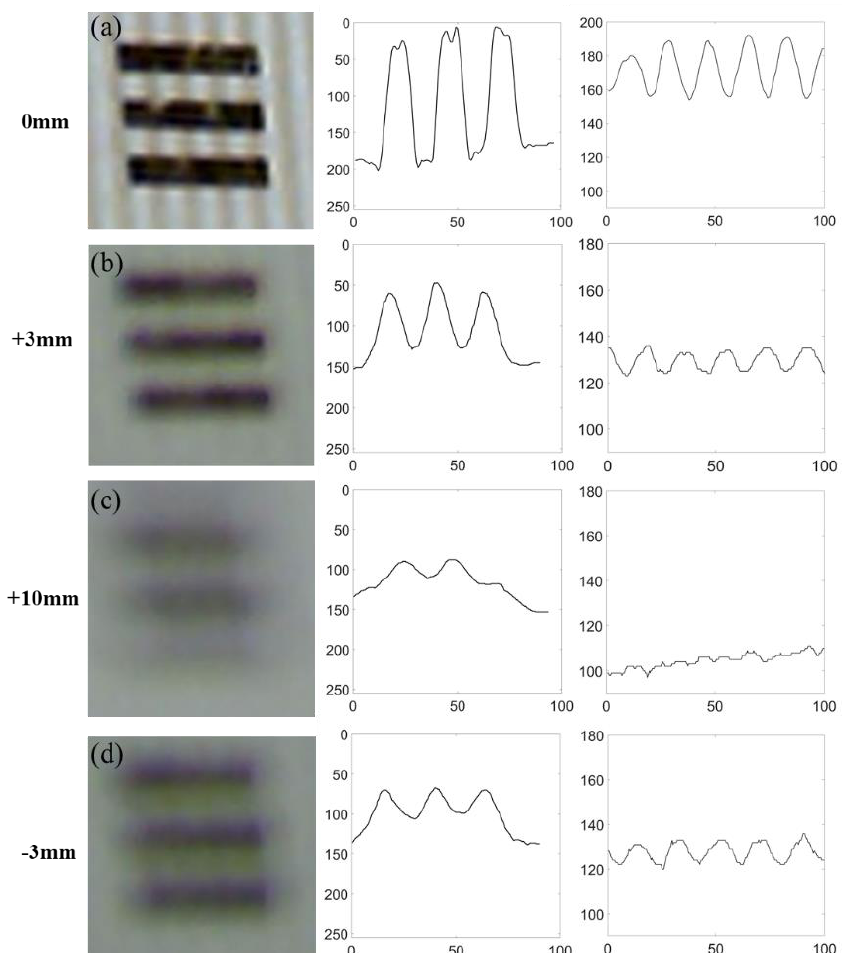
Figure 4. Resolution of the system at different positions. The four figures on the left show the image captured by the CCD camera. The four figures in the middle show the contrast of the horizonal resolution test chart. The four figures on the right show the contrast of the structured light with vertical stripes. For all four figures in the middle, and four figures on the right, the horizontal axes show the distance with units of micrometers, and the vertical axes show the 8-bit grey scale (0 − 255). Zero indicates that the test chart overlaps with the focus points of both the imaging system and the projection system ( a ). Positive sign indicates that the test chart moves away from the system (( b , c )) and negative sign means the test chart moves towards the system ( d ).